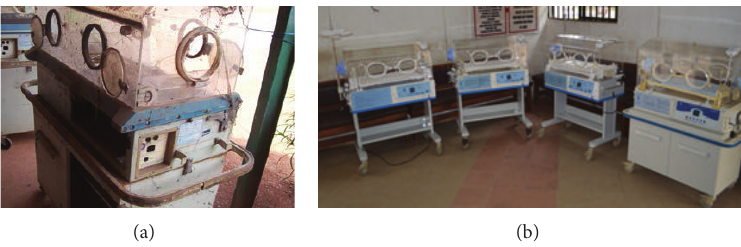
Figure 1: Incubators. (a) Casing recovered from a hospital dump site for recycling. (b) A fleet of recycled systems just before commissioning at FMC